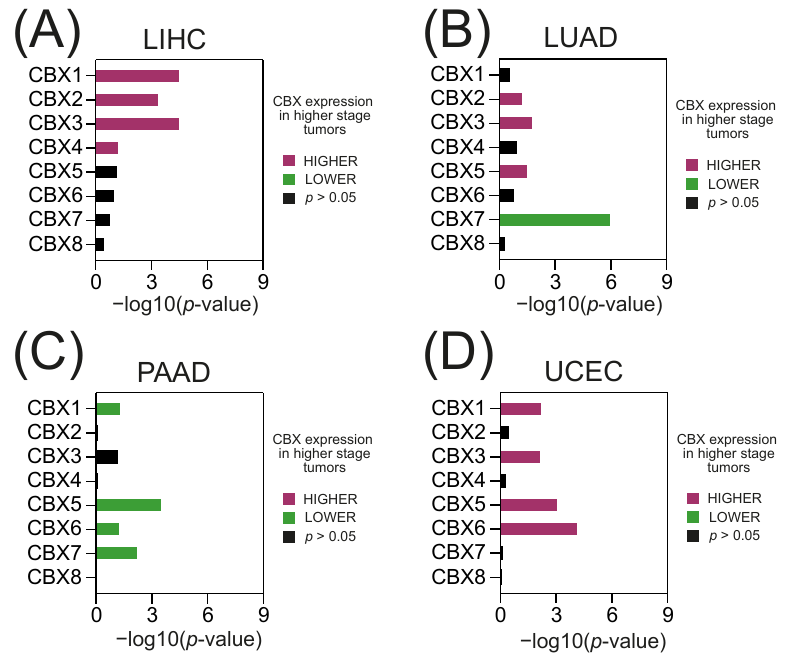
Figure 3. The association between CBX family members and disease stage in selected TCGA tumors. The association between CBXs expression and tumor stage—either lower (green) or higher stage (purple), as determined with the Spearman correlation test ( − log10( p -value)) in ( A ) LIHC, ( B ) LUAD, ( C ) PAAD, and ( D ) UCEC